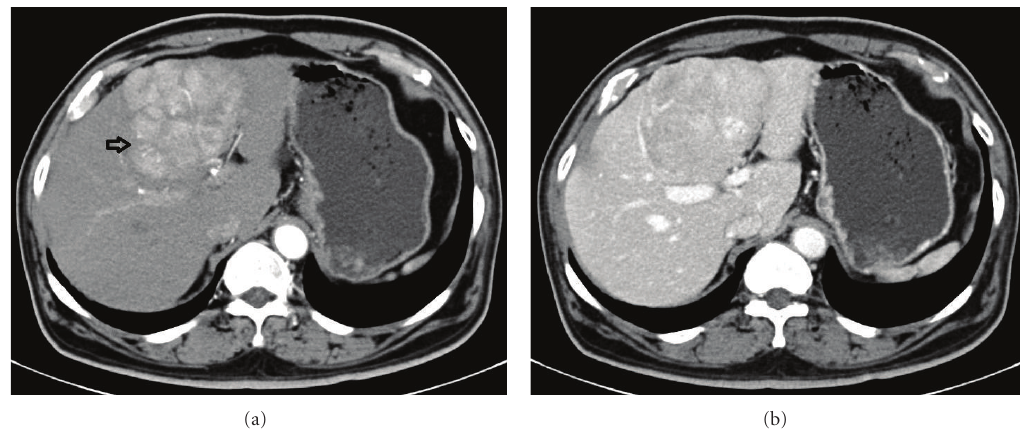
Figure 1: Contrast-enhanced CT scan of NASH-associated HCC. (a) This arterial-phase image shows an enhancing lesion (arrow) in the left lobe of a steatotic liver. No gross radiographic evidence of cirrhosis is present. (b) The same tumor shows hypoenhancement or “washout” in the delayed portal venous-phase